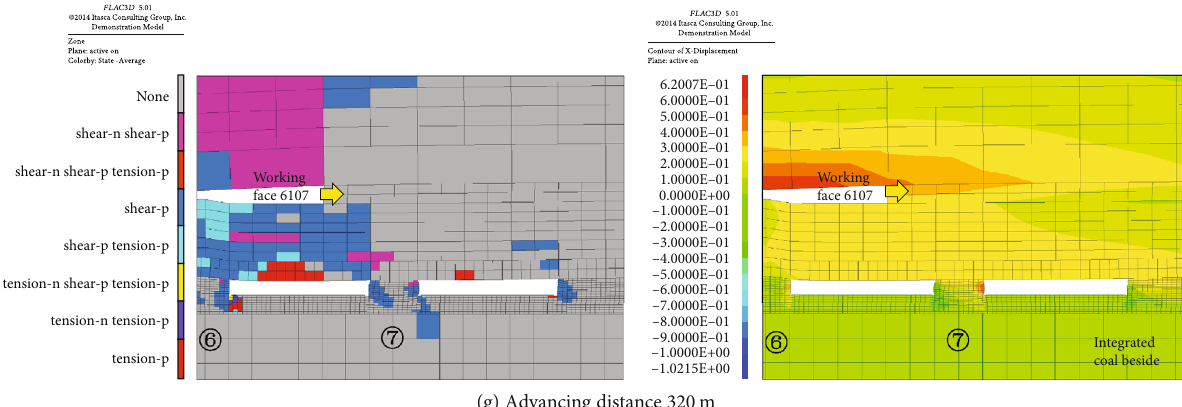
Figure 9: The elastoplastic expansion and the amount of the horizontal bulge of each coal pillar with a fi lling body height of 4